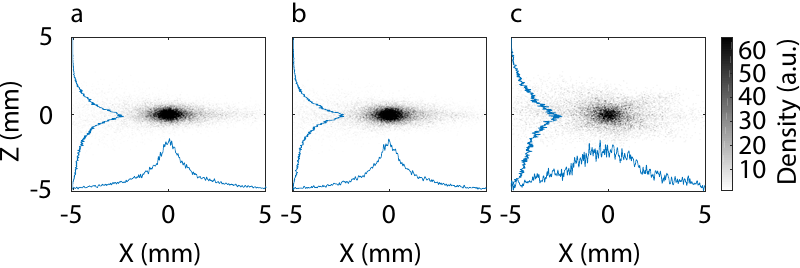
Figure 12. Simulated transversal beam shape at the undulator center for ( a ) a 2 = 0, the ( b ) low and ( c ) high a 2 (Table 2). ’Slit-undulator’ optics (slit open to 3.2 mm corresponding to a slice of 176 ± 7 MeV). Initial low divergence beam distribution of Figure 2a with σ (cid:48) (cid:101) z , i , (cid:101) x , i = 0.2